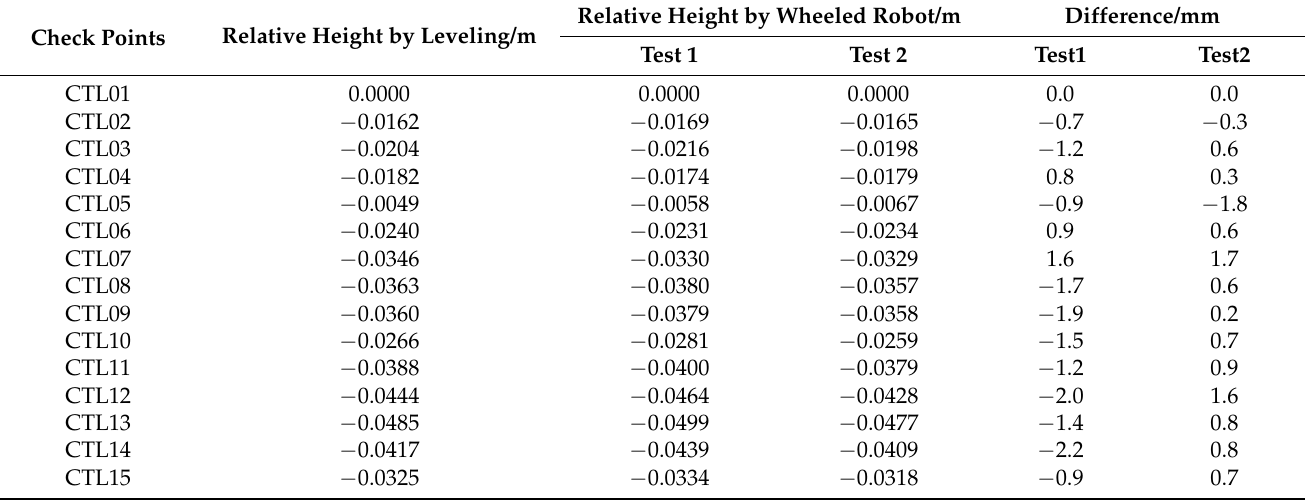
Table 2. Relative height comparation of all check points on the routine.